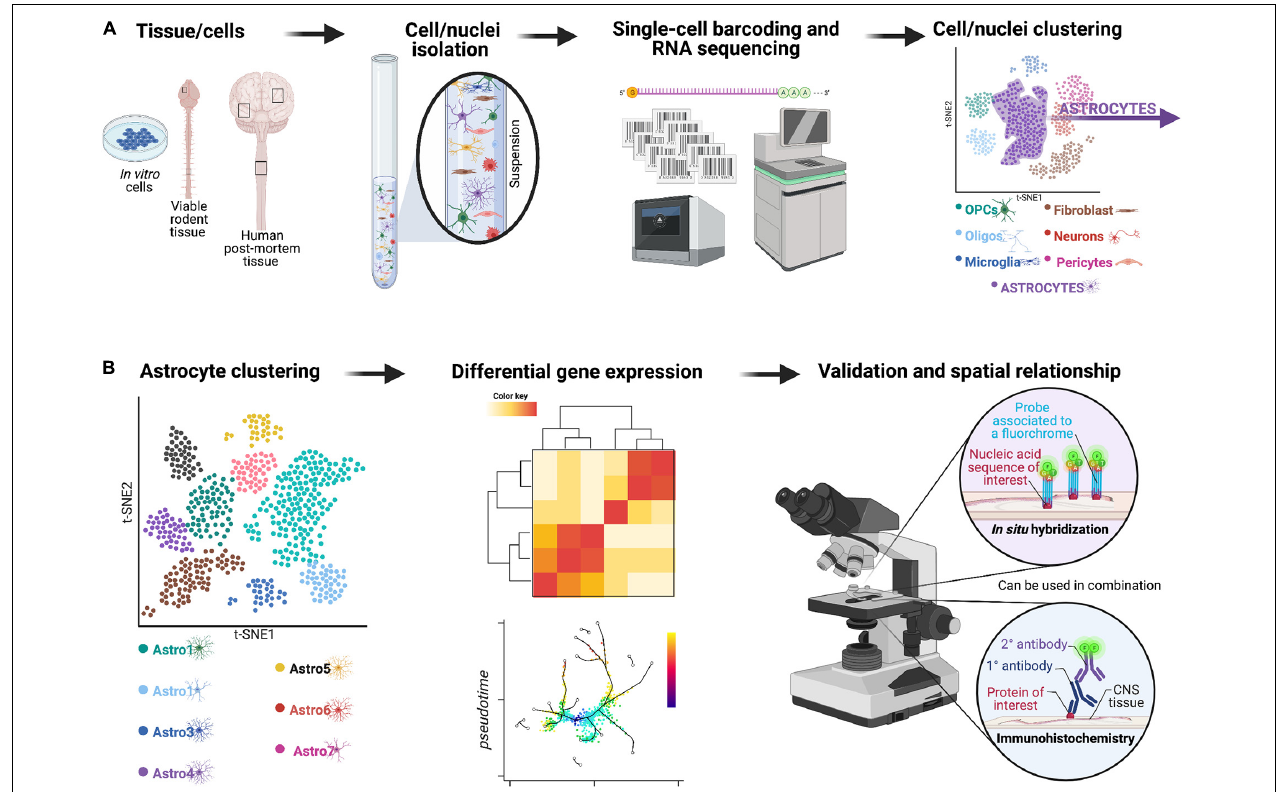
FIGURE 2 | Overview of a potential workflow featuring droplet-based sc/snRNA-seq approaches to investigate astrocyte diversity across different CNS pathologies. (A) In the past few years, a technological revolution in RNA-sequencing technology has made it possible to profile the entire transcriptome of individual cells on a massive scale—a technique known as single-cell RNA-sequencing or scRNA-seq (Svensson et al., 2018). Initially, scRNA-seq relied on manual cell picking (Van Gelder et al., 1990; Eberwine et al., 1992) or FACS-based sorting (Ramsköld et al., 2012; Shalek et al., 2013). Innovative analyses revealed a surprising degree of transcriptional heterogeneity in seemingly homogenous cell populations. Subsequent advances in microfluidic instrumentation (Shalek et al., 2014; Treutlein et al., 2014) and droplet-based methods (Klein et al., 2015; Macosko et al., 2015) have since driven experimental costs down significantly to now permit sequencing of tens to hundreds of thousands of cells in a single experiment (Cao et al., 2017; Schaum et al., 2018). The rapid pace of methodological and computational progress has fostered initiatives to profile the mRNA landscape within every single cell of various model organisms (Cao et al., 2017; Schaum et al., 2018) and, ultimately, in humans (Rozenblatt-Rosen et al., 2017). This framework now enables comprehensive interrogation of the molecular etiology of human disease at single-cell resolution (Stubbington et al., 2017; Cheung et al., 2019). For example, single-cell transcriptomics offers an opportunity to elucidate how individual types of cells coordinate their activity to drive pathophysiological processes, and how cell type-specific responses might be targeted to treat disease. Indeed, in only the past few years, scRNA-seq has been applied to asthma (Braga et al., 2019), inflammatory bowel disease (Martin et al., 2019; Parikh et al., 2019; Smillie et al., 2019), obesity (Svensson et al., 2018), Alzheimer’s disease (Mathys et al., 2019), and TBI (Arneson et al., 2018), among other disorders. These technologies and analyses enable clustering of all viable cells/nuclei included in the original sample based on gene expression, and for example to identify astrocyte-like subpopulations can be isolated for further analyses. (B) The astrocyte-like subpopulations can be further clustered and examined using approaches, such as differential gene expression to yield important information about heterogeneous astrocyte populations.